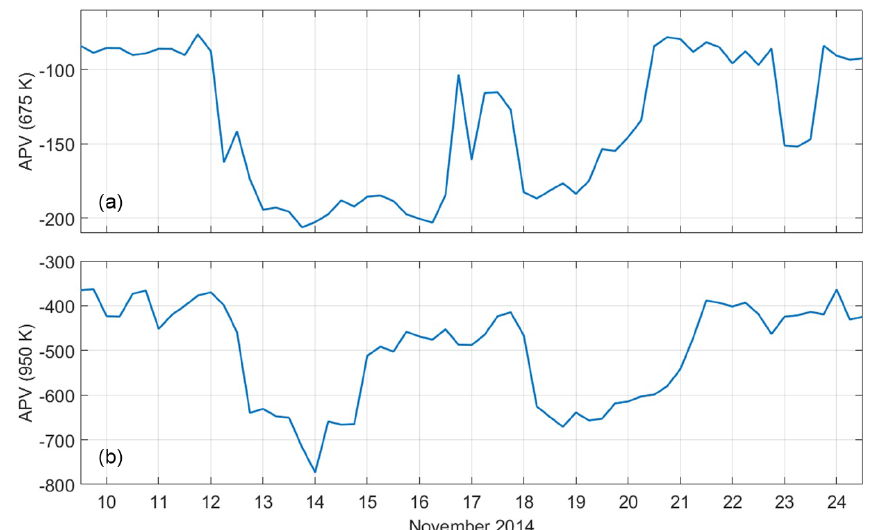
Figure 9. Time evolution of advected potential vorticity assimilated with the MIMOSA model over Río Gallegos ( − 51.6; − 69.3) at 675K (a) and 950K (b)